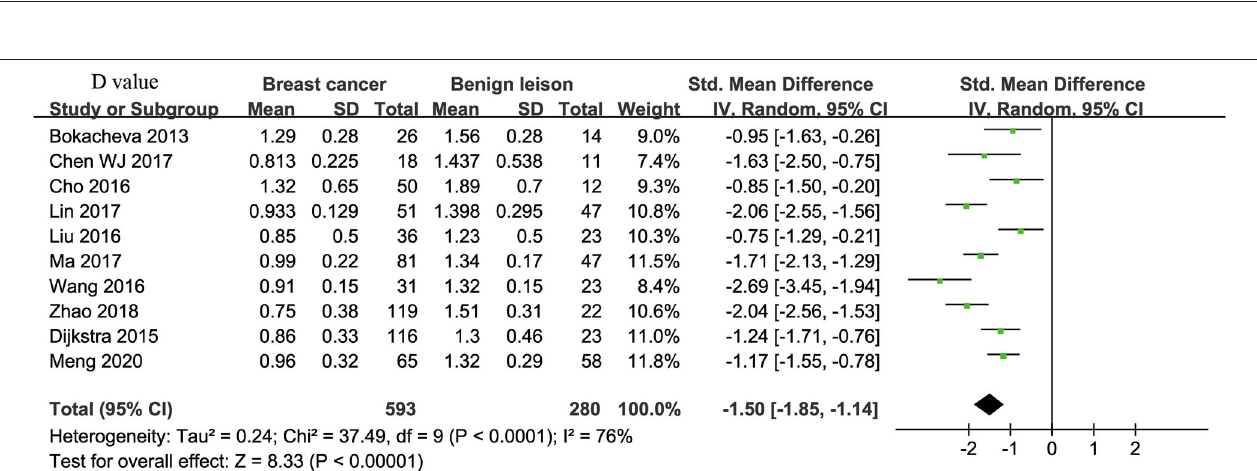
FIGURE 3 | Forest plot of the mean value of the apparent diffusion coefficient (ADC) between malignant and benign breast lesions. The standardized mean differences (SMDs) indicated that breast cancers had a significantly lower ADC than benign lesions.